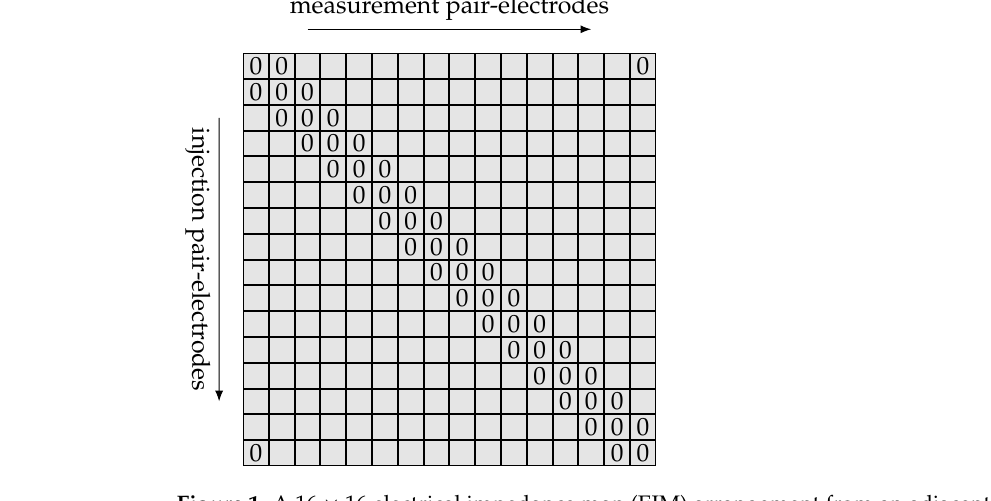
Figure 1. A 16 × 16 electrical impedance map (EIM) arrangement from an adjacent injection pattern. The zeros represent values which are not gathered from adjacent–adjacent measurement mode, as at least one electrode is used for current